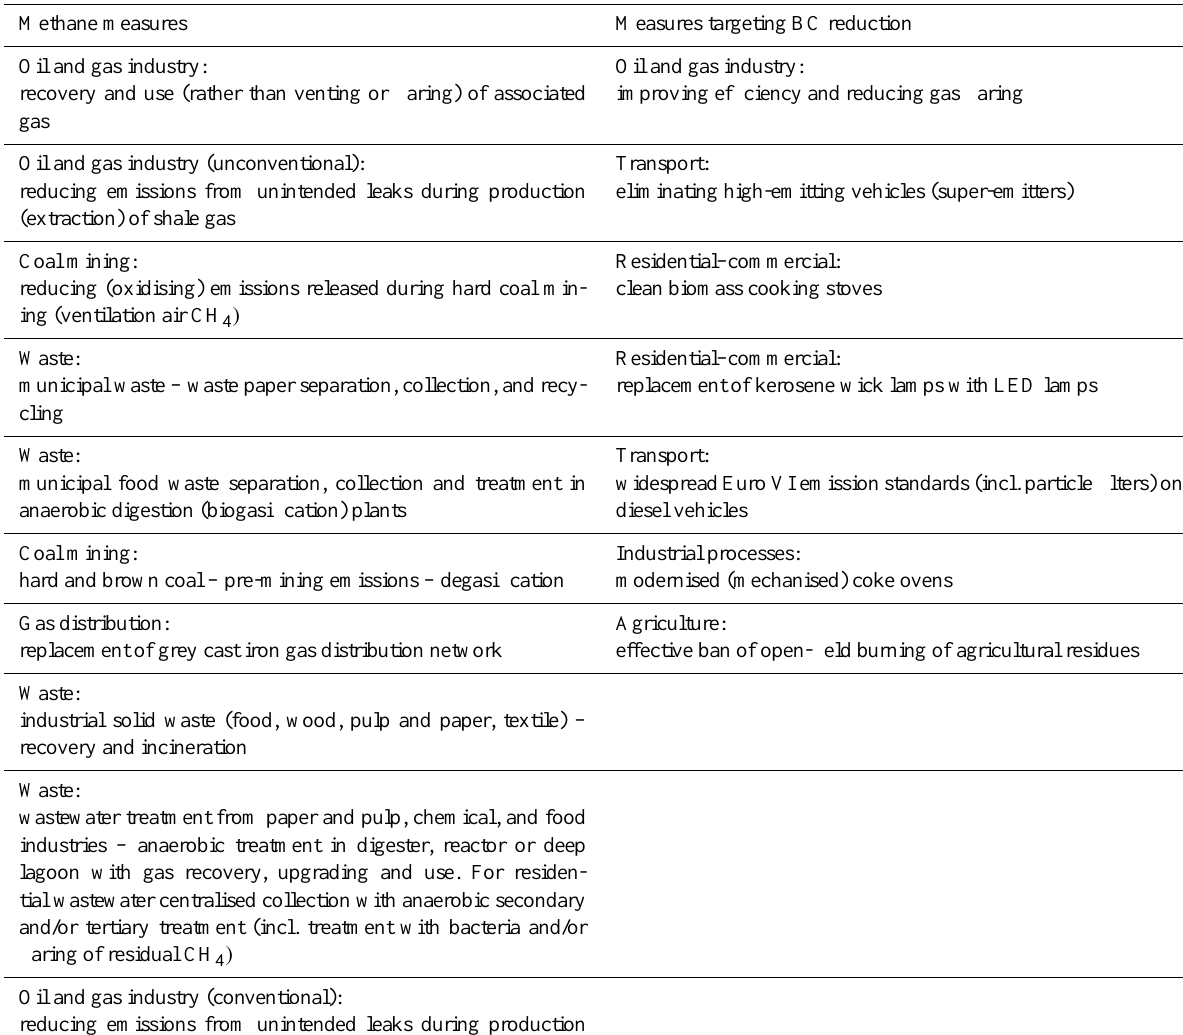
Table 3. Top-17 mitigation measures contributing together more than 80% of the climate benefit. Measures are ranked by importance starting from the top. Methane measures contribute about 47% of the benefits according to the GTP 20 metric, while 33% are attributed to BC-focused measures; 20% are contributed by measures not listed